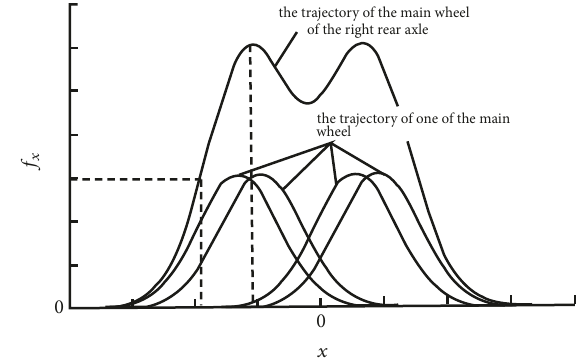
Figure 5: Wheel trajectory distribution of main wheels of rear axle (after